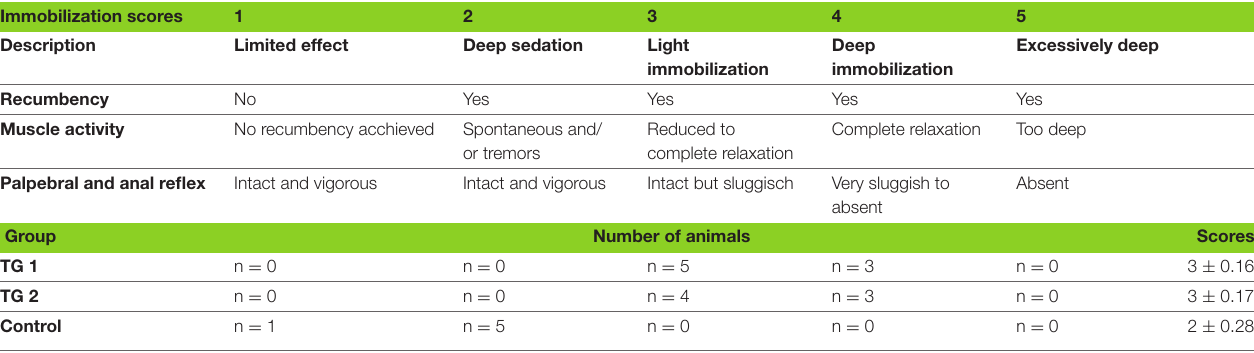
TABLE 3 | Distribution of scores representing the quality of immobilisation in TG a 1: ketamine–medetomidine–midazolam–butorphanol (KMMB), TG 2: tiletamine–zolazepam–medetomidine–butorphanol and CG b : etorphine–acepromazine–detomidine–butorphanol (EADB) immobilized kulans (Equus hemionus kulan). Immobilization scores